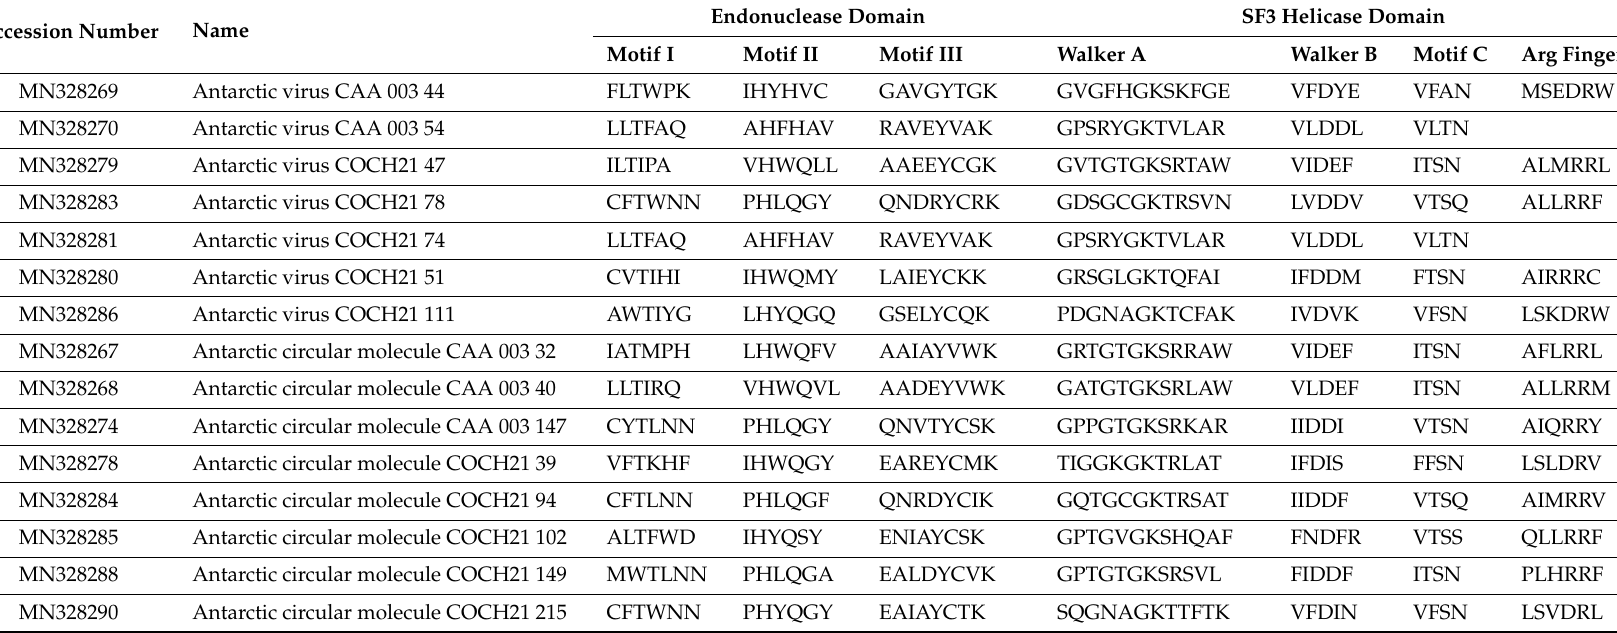
Table 2. Summary of the rolling circle replication (RCR) motifs of the endonuclease and SF3 helicase domains of the Reps encoded by viruses and circular molecules identified in this